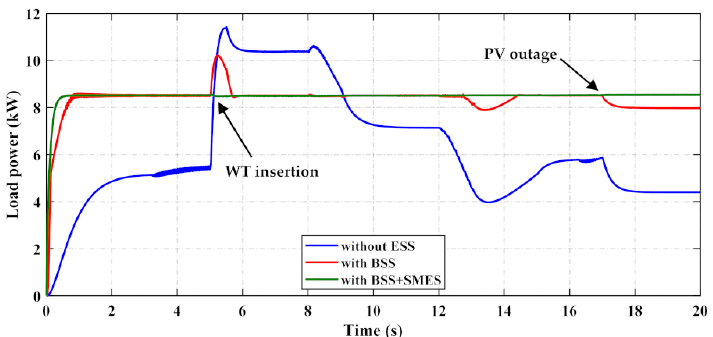
Figure 14. Load power during the three examined cases.